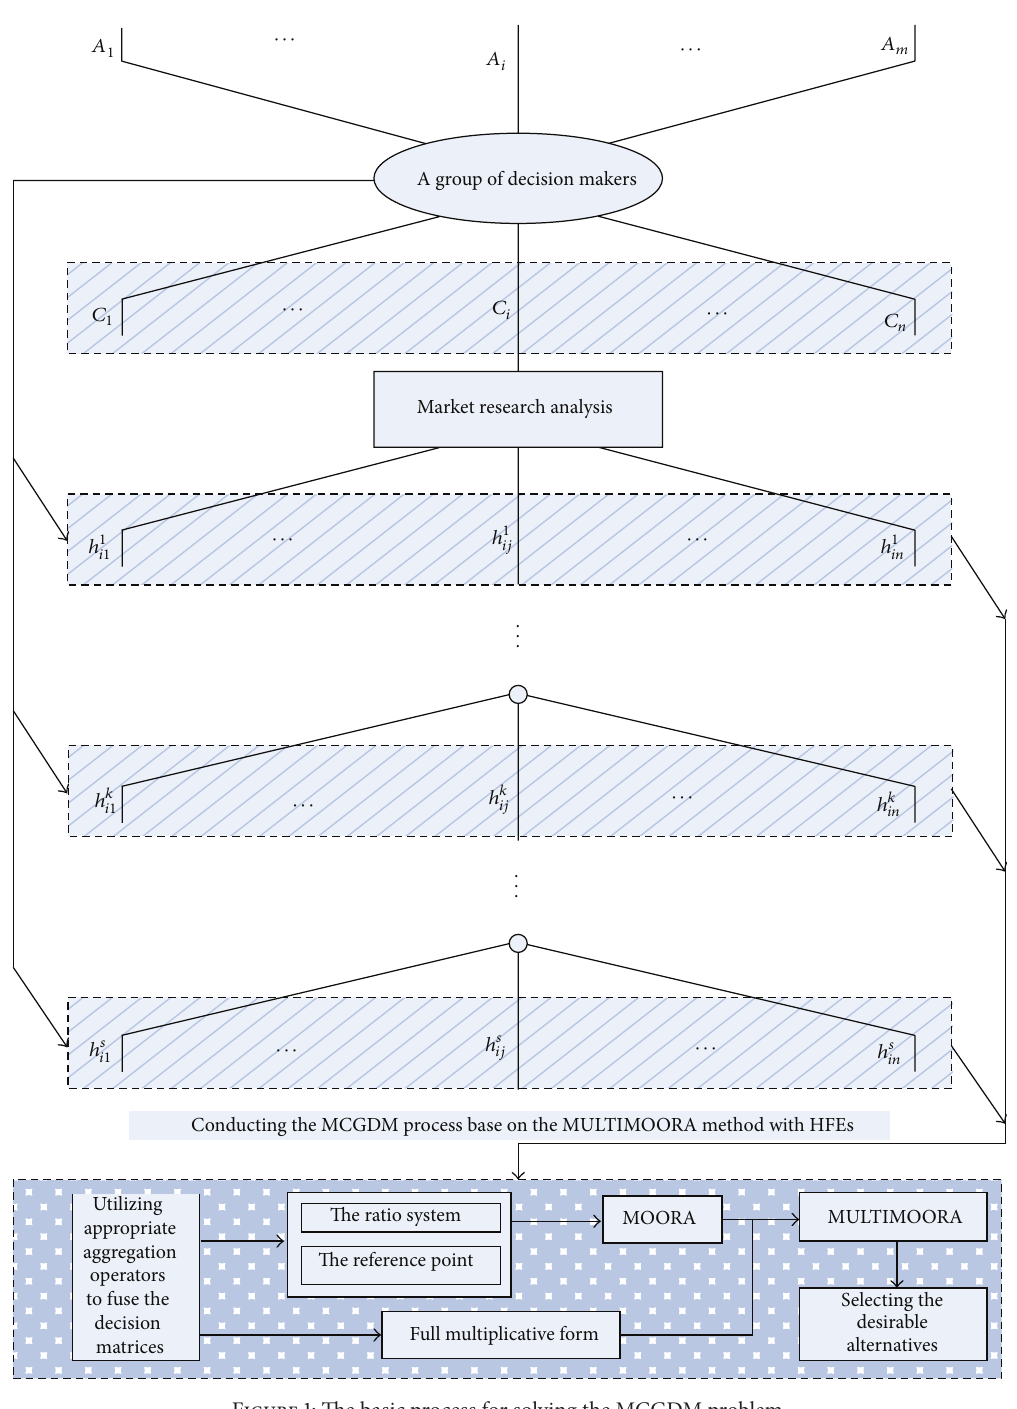
Figure 1: The basic process for solving the MCGDM